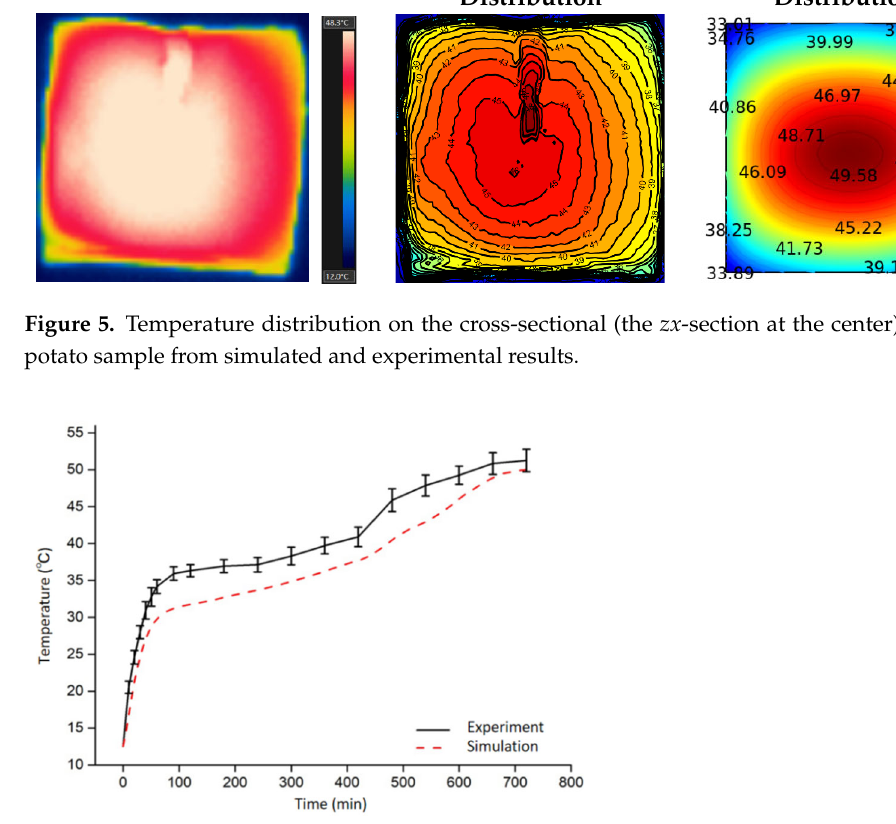
Figure 7. Moisture content of potato samples during RF drying from both simulation and experi ‐ ment. Figure 8 shows the water distribution inside the sample from modeling after 12 h of drying. The water concentration in the sample is non ‐ uniform, and the maximum differ ‐ ence of water concentration within the volume is 0.03 g ∙ cm − 3 . The moisture distributions within the sample corresponded to the temperature–time history inside the sample during drying: the central area had a higher water concentration than the corner. A similar water concentration distribution pattern was also reported for kiwifruit slices in RF–vacuum